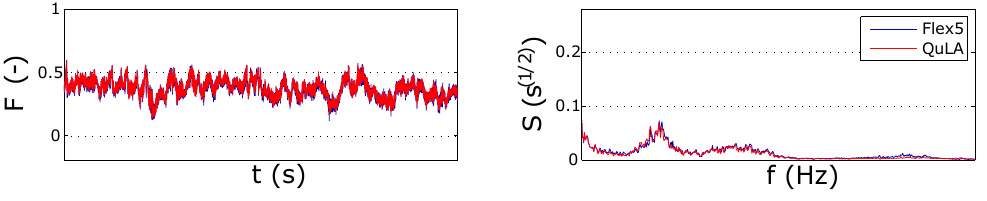
Figure 14. Sectional force 26m above the SWL for load case 1.2. The force time series are normalized with the largest force at the seabed in the Flex5 calculations.